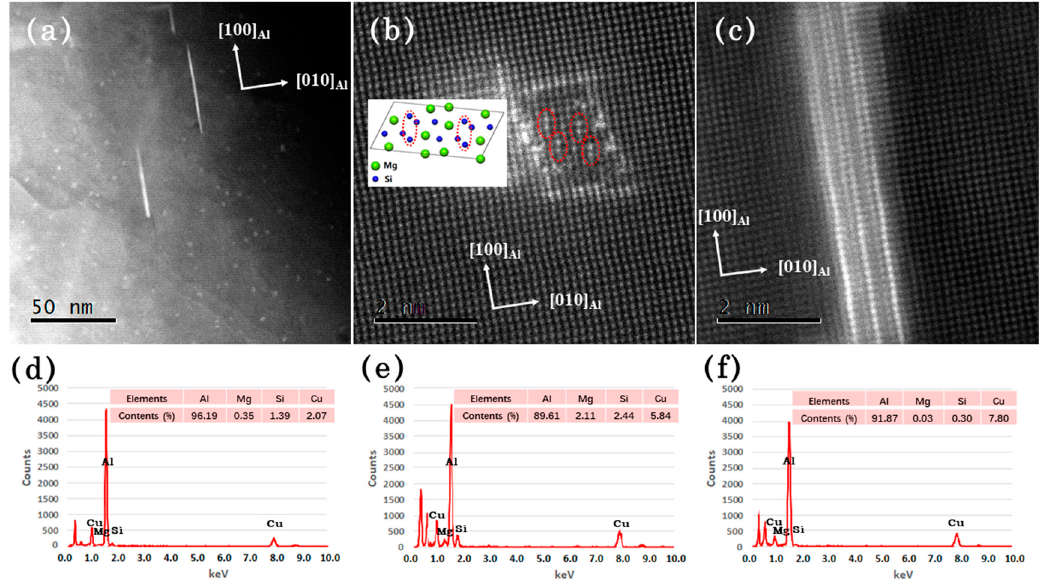
Figure 11. Low magni fi cation HAADF-STEM images of Al-7%Si-0.3%Mg-0.3%Cr-1.5%Cu alloy ( a ), atomic resolution HAADF-STEM images of 𝛽′′ ( b ) and 𝜃′′ ( c ), and EDS spectrums of Al matrix ( d ), atomic resolution HAADF-STEM images of β (cid:48)(cid:48) ( b ) and θ (cid:48)(cid:48) ( c ), and EDS spectrums of Al matrix ( d 𝛽′′ ( e ) and 𝜃′′ ( f ).